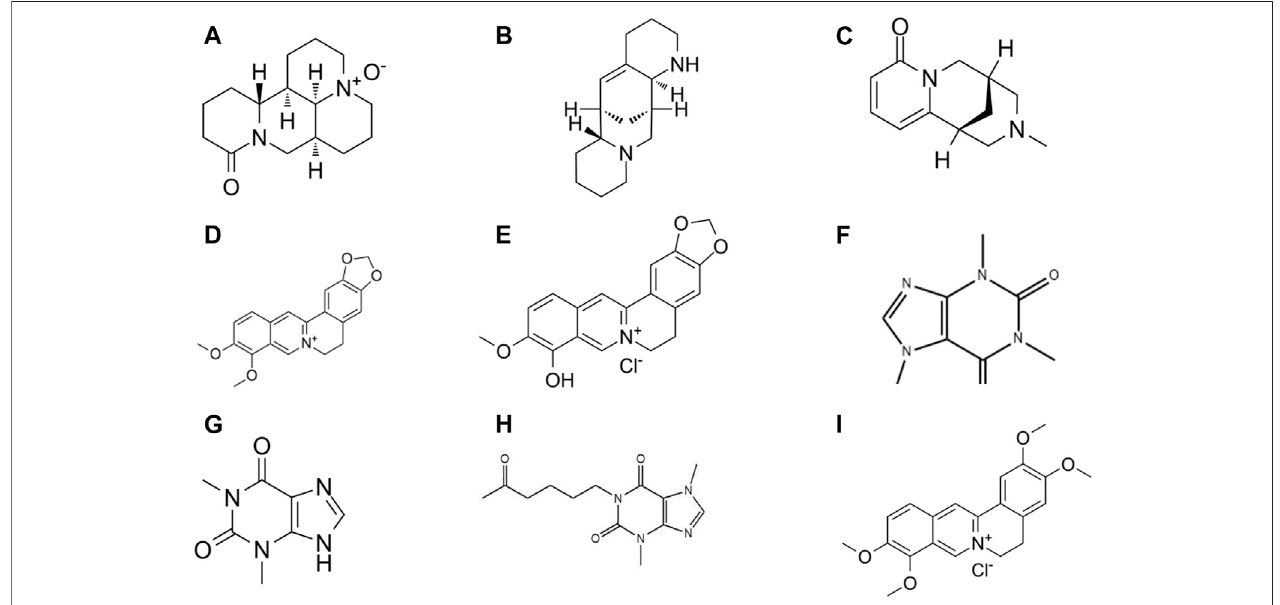
FIGURE 5 | Chemical structures of alkaloid phytochemicals: (A) Oxymatrine (B) Aloperine (C) N-methylcytisine (D) Berberine (E) Berberrubine (F) Caffeine (G) Theophylline (H) Pentoxifylline (I) Palmatine.